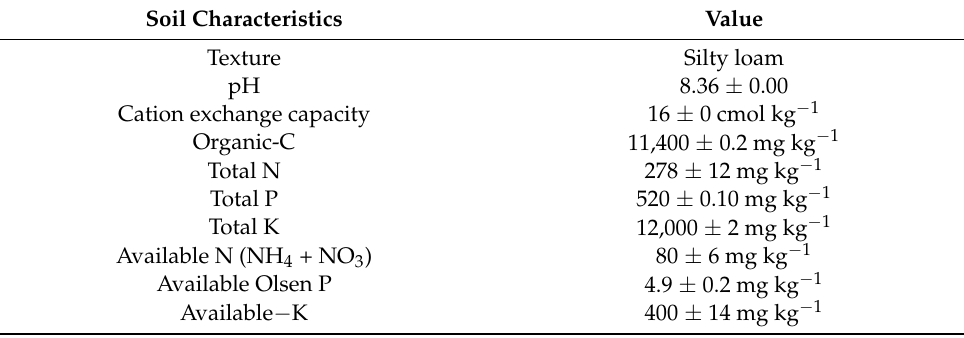
Table 1. Basic soil properties before